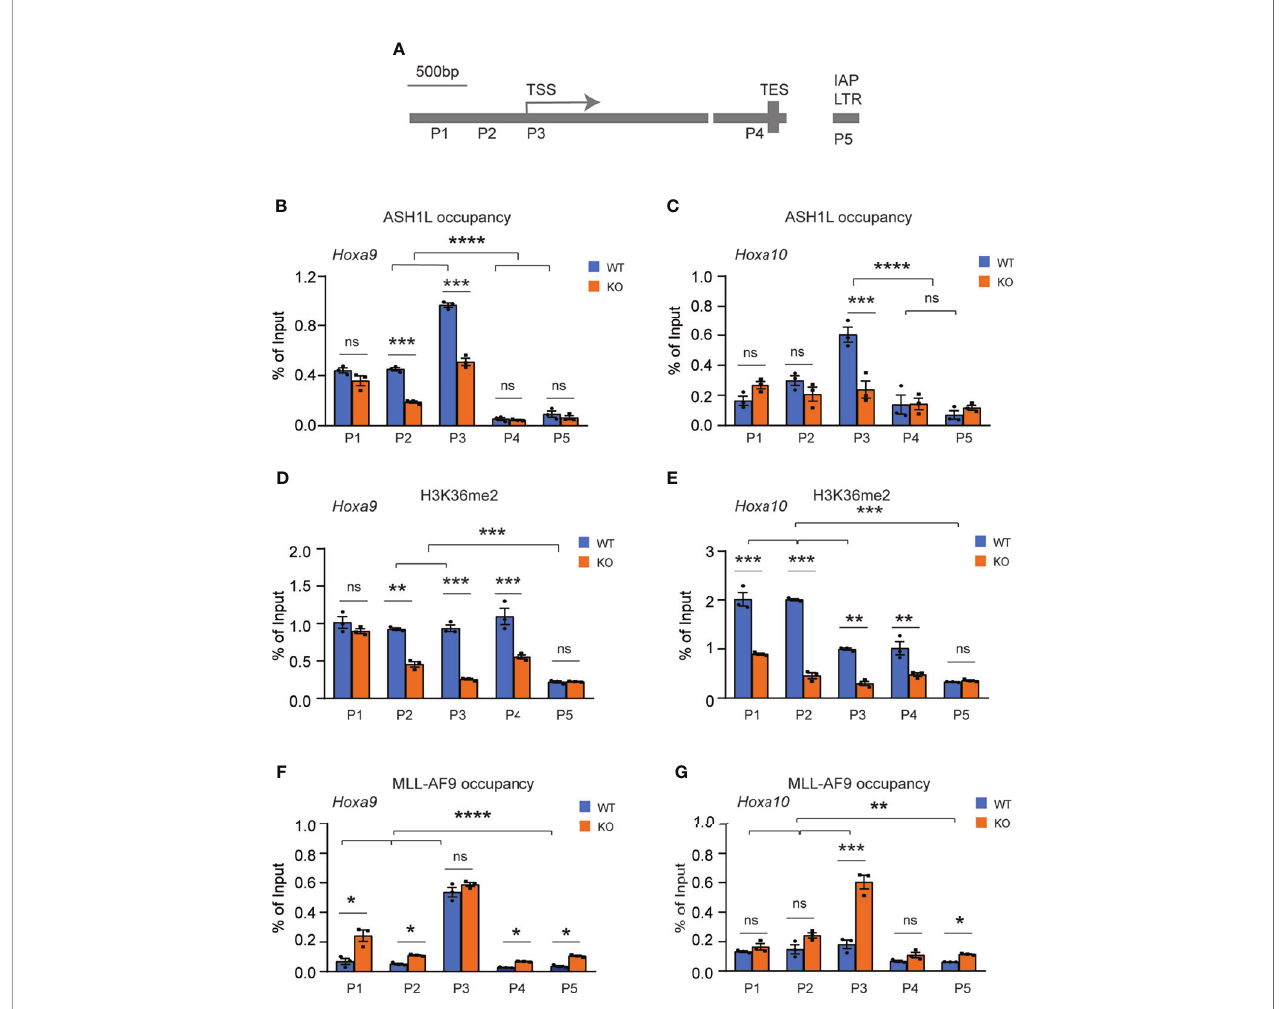
FIGURE 6 | ASH1L binds and mediates histone H3K36me2 modi fi cation at Hoxa9 and Hoxa10 gene promoters. (A) Plot showing the locations of ChIP-qPCR amplicons at the Hoxa9 and Hoxa10 gene loci and LTR of intracisternal A-particle (IAP). (B, C) ChIP-qPCR analysis showing the ASH1L occupancy at Hoxa9 and Hoxa10 gene loci in the wild-type and Ash1L -KO MLL-AF9-transformed cells. (D, E) ChIP-qPCR analysis showing the histone H3K36me2 at Hoxa9 and Hoxa10 gene loci in the wild-type and Ash1L -KO MLL-AF9-transformed cells. (F, G) ChIP-qPCR analysis showing the MLL-AF9 occupancy at Hoxa9 and Hoxa10 gene loci in the wild-type and Ash1L -KO MLL-AF9-transformed cells. Note: for panels (B – E) , the error bars represent mean ± SEM, n = 3 biological replicates. * P < 0.05, ** P < 0.01, *** P < 0.001; **** P < 0.0001; ns, not signi